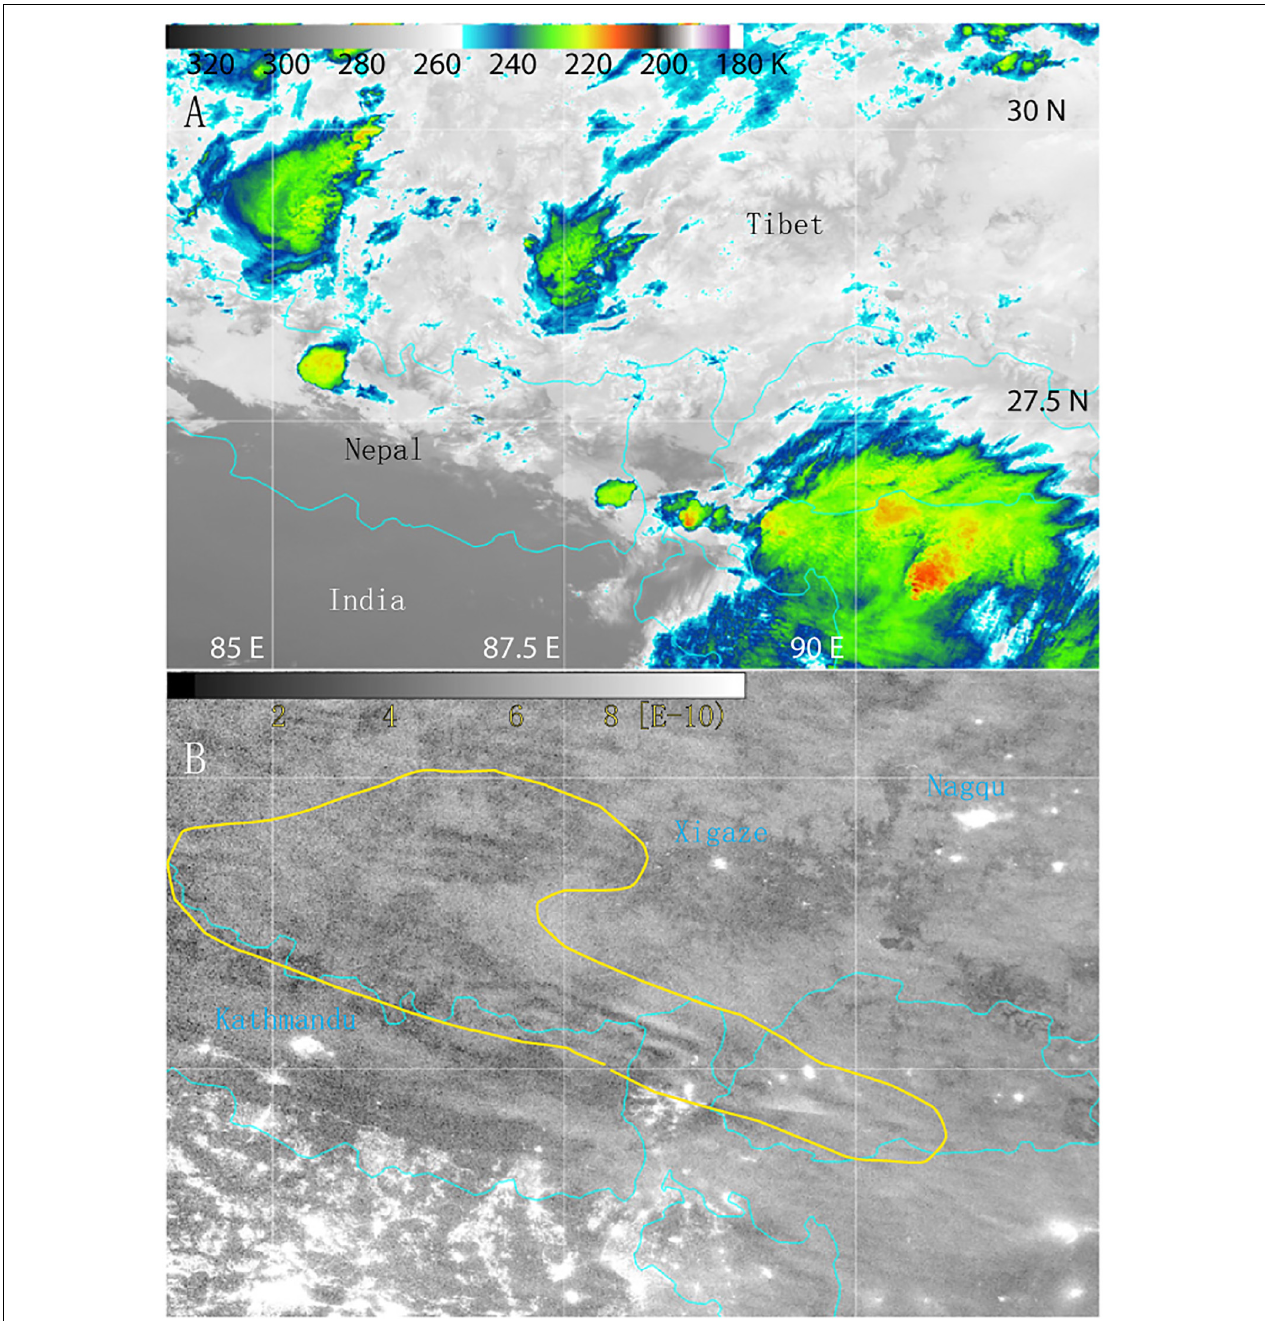
FIGURE 1 | (A) VIIRS thermal infrared (10.76 µ m) image over the Tibetan Plateau at 19:22 on 3 May 2014; (B) The visible/near-infrared image of the corresponding Suomi satellite DNB; the yellow outline shows the central signal area of the gravity wave (Miller et al., 2015).